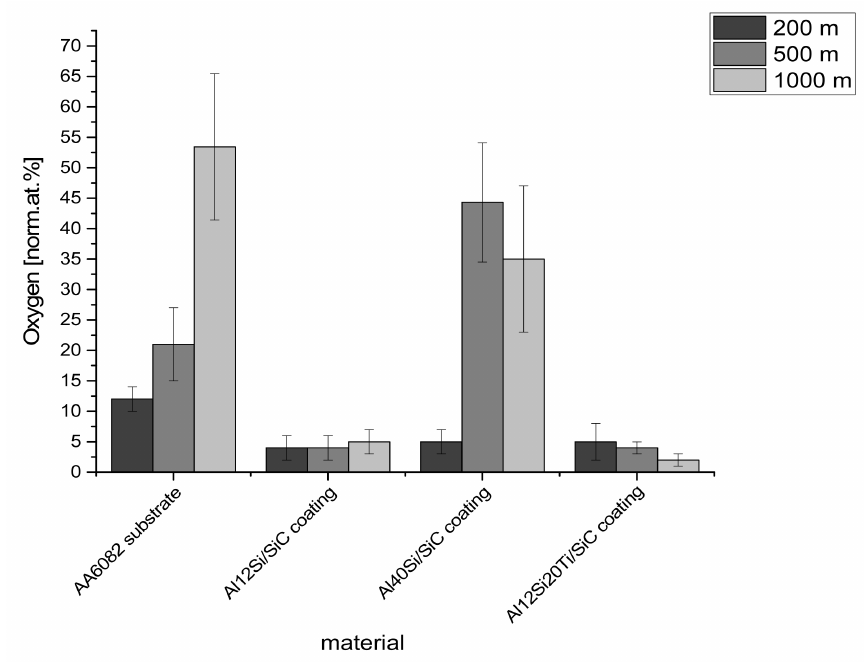
Figure 8. Oxygen percentage [norm. at.%] present on the worn surface of the uncoated AA6082 and the different coatings (Al12Si/SiC, Al40Si/SiC, and Al12Si20Ti/SiC) compared to the sliding distances (200, 500, and 1000